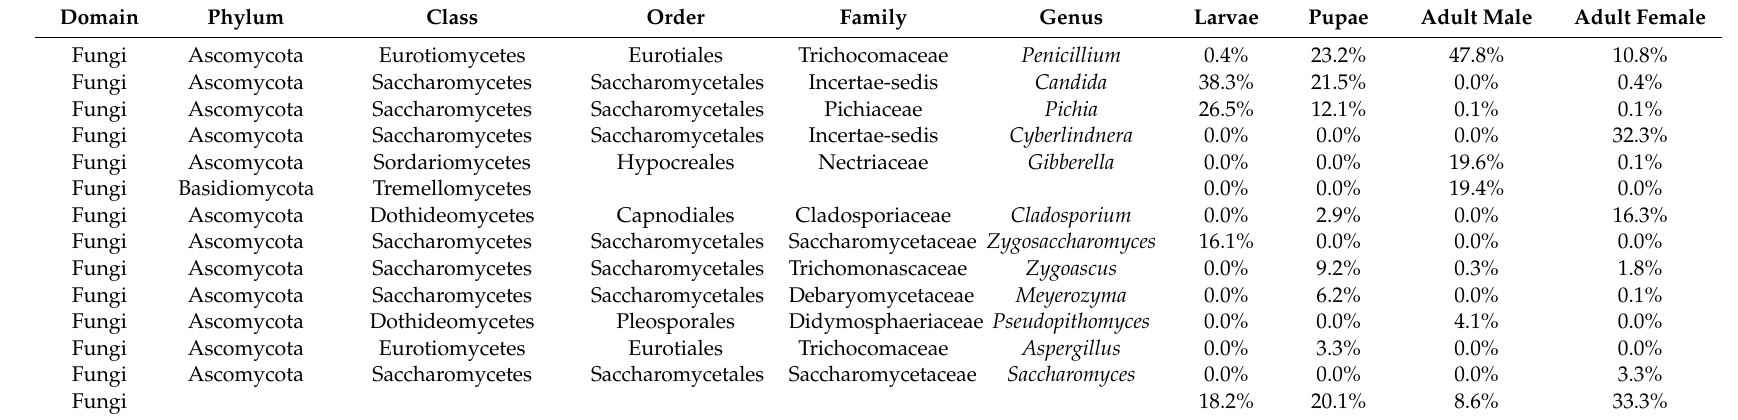
Table 2. Taxonomic identification of the 14 most abundant fungal taxa in the Qfly across all developmental stages (% based on genus level).